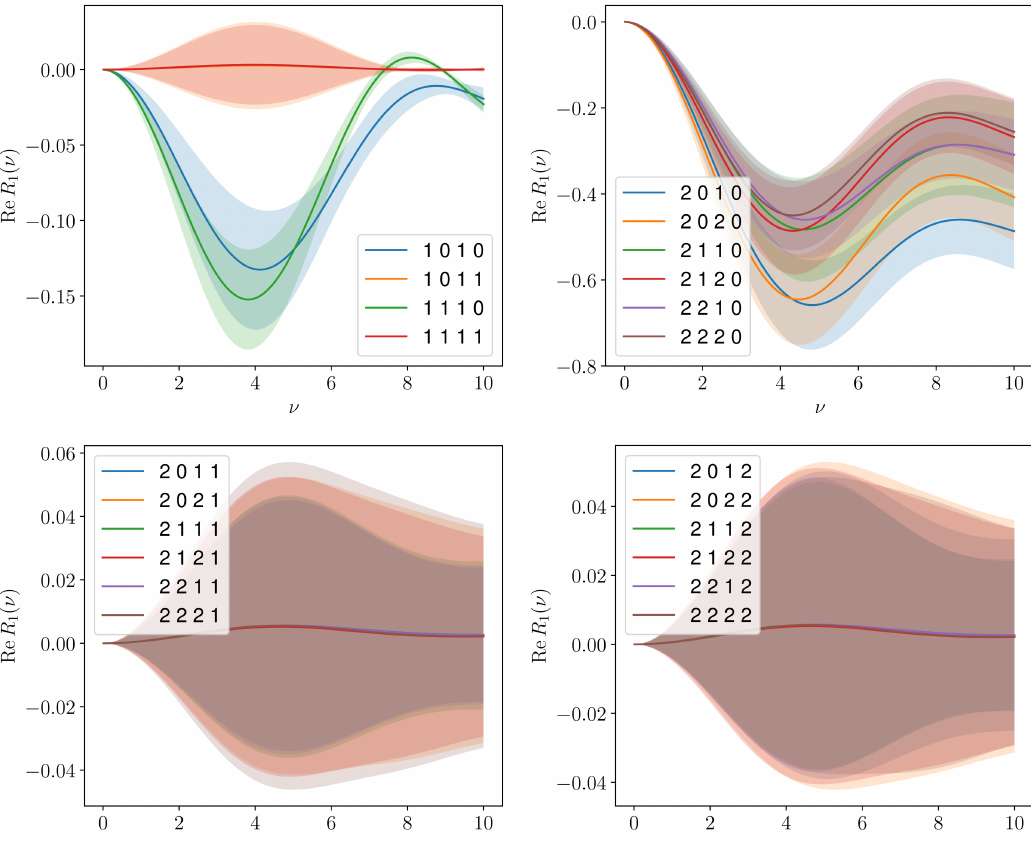
Figure 24 . The higher twist term, B 1 , results from fitting the real component to the models. The numbers in the legend correspond to ( N ± , N